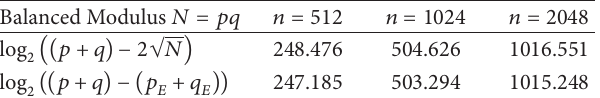
Table 2: The improvement of EPF on 𝑝 + 𝑞 , where 𝑝 and 𝑞 are